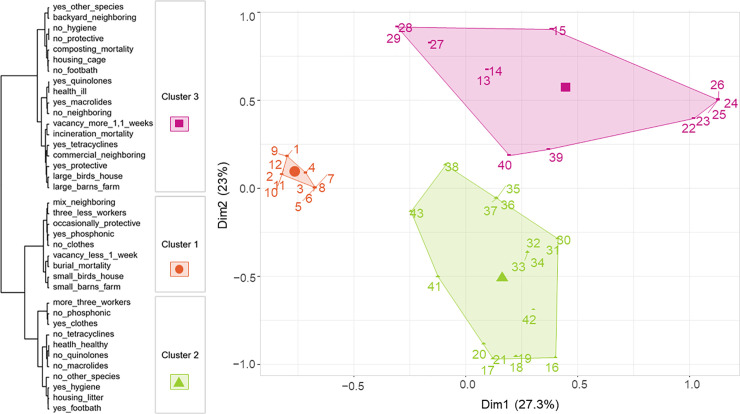
Projection of the 43 Mexican commercial poultry farms included in the study within the three clusters identified through the HCA and plotted in the first two dimensions of the Euclidean space.The dendrogram shows the categories of variables that most characterize the farms within each cluster.